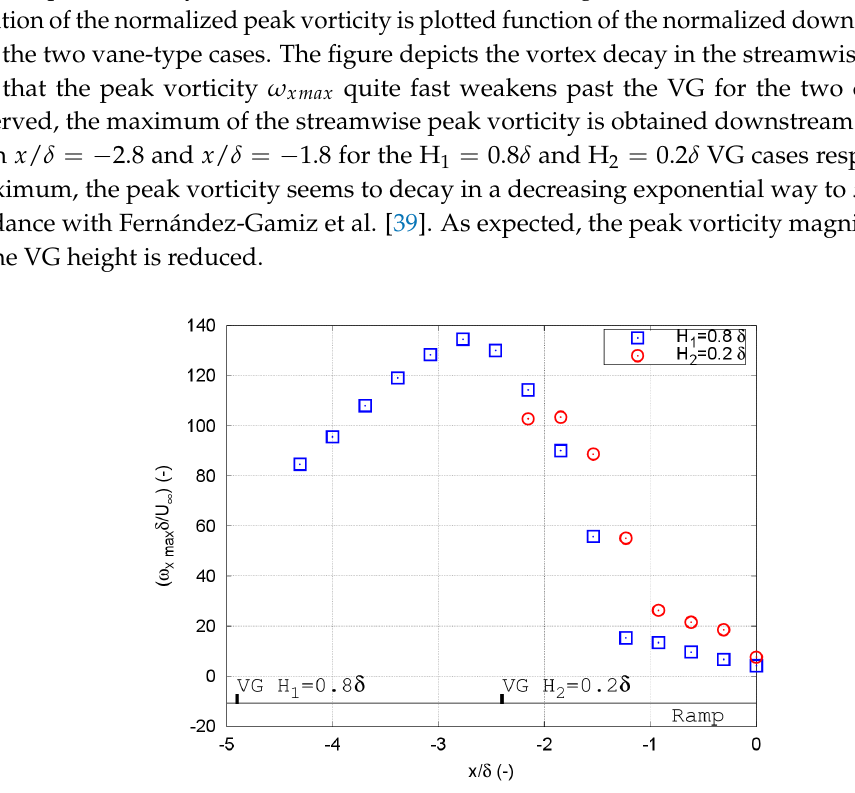
Figure 12. Non-dimensional streamwise peak vorticity ( ω xmax δ )/ U ∞ function of the normalized distance x / δ for the H 1 = 0.8 δ (blue rectangles) and H 2 = 0.2 δ (red circles) vane-type VG cases. VGs, flat plate and ramp also shown (not at